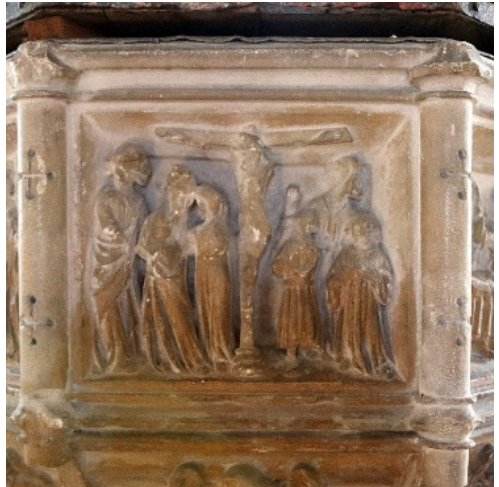
Figure 20. Crucifixion. Source: Bob Mitchell.